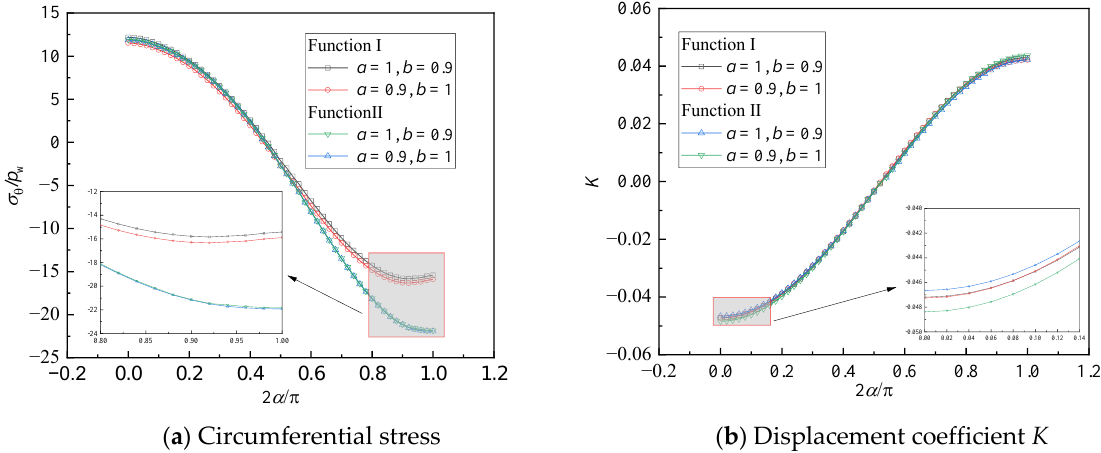
Figure 16. Comparison of mechanical properties of functionally graded lining under two elastic modulus functions.